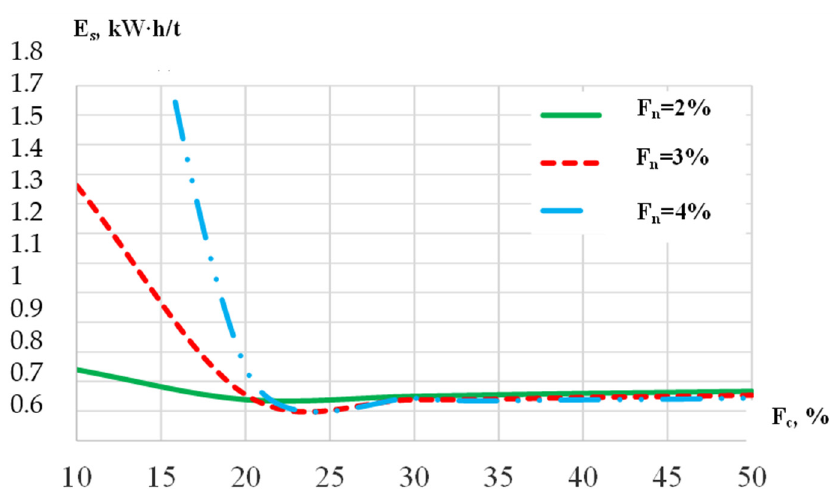
Figure 5. Dependence of the specific energy consumption E s on the fat content of cream F c and normalized milk F n (at d k = 3 mm; F s = 0.05%; h = 0.5 mm; µ B = 0.3; Q = 1000 kg/h, µ k = 0.98).